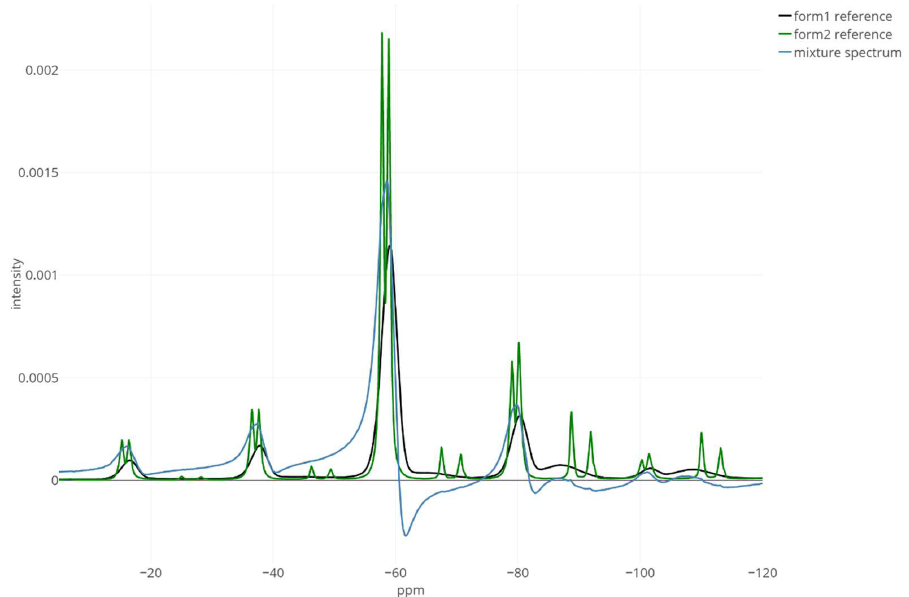
Figure 4. The before-deconvolution visualisation of the 3%-crystalline mixture spectrum (in blue) together with the 100% pure amorphous (“form1”, the black line) and 100% pure crystalline (“form2”, the green line) templates. The discussed processing and deconvolution challenges are now clearly visible: severe peak overlap, large phase error of the mixture, and broad peaks of the amorphous component. Only spectrum real parts are shown. The x-axis range was limited to −5 and −120 ppm for better visibility.